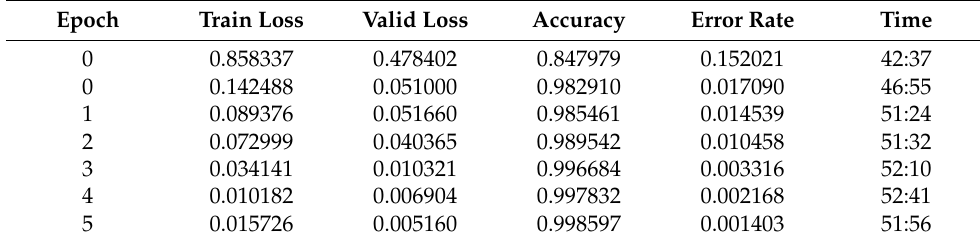
Table 2. Results of the ResNet